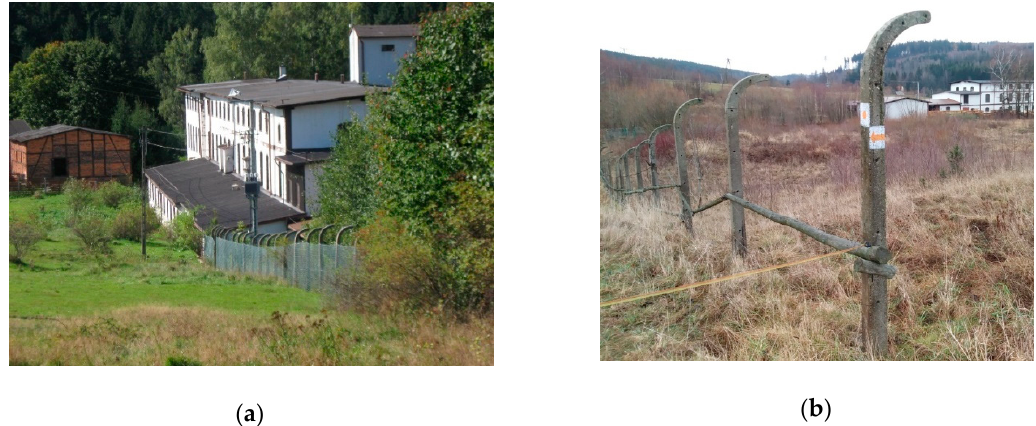
Figure 10. The remains of the fence surrounding the former AL Dörnhau camp: ( a ) the southern part of the factory building (white walls) and a row of concrete fence posts with modern fencing mesh; ( b ) the row of concrete post fence is restricting the former camp area from the northeast; in the background factory buildings; photos: A. Burakowski.